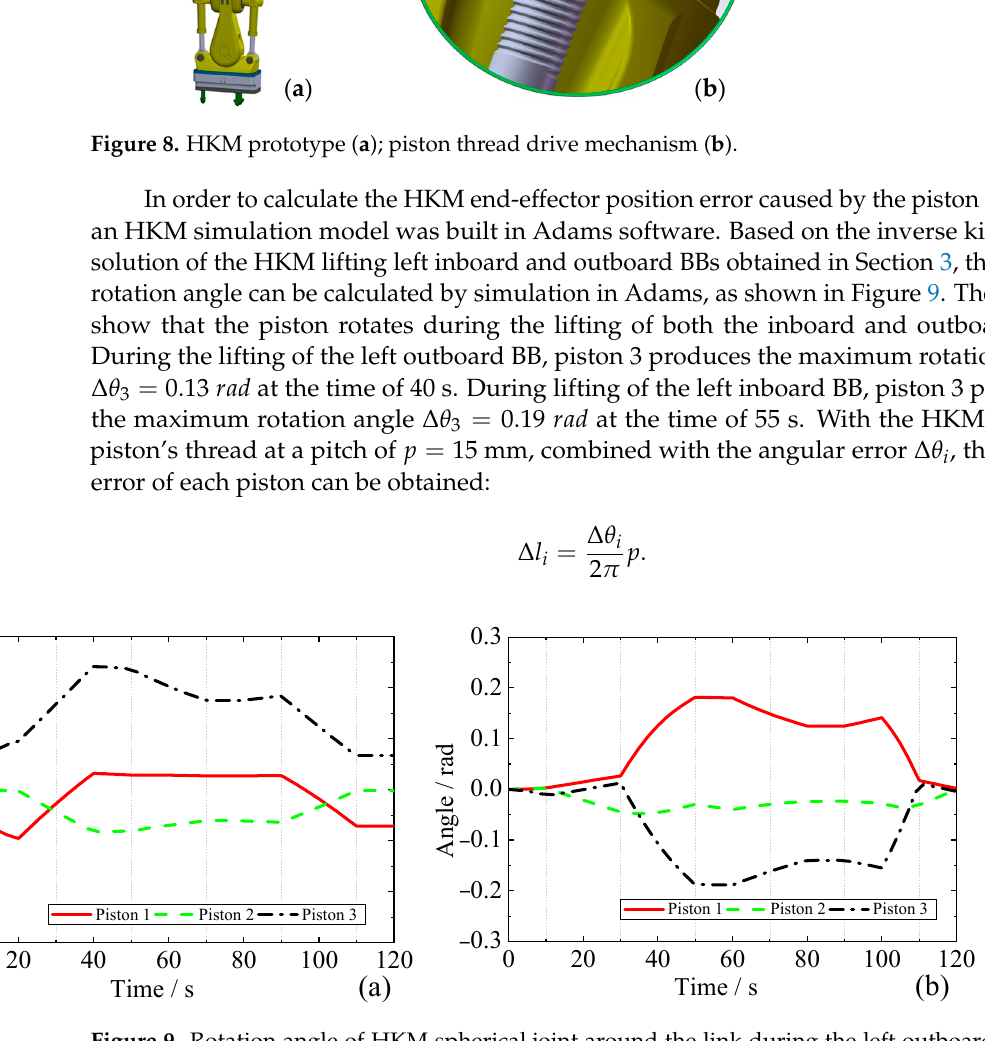
Figure 8. HKM prototype ( a ); piston thread drive mechanism ( b ).